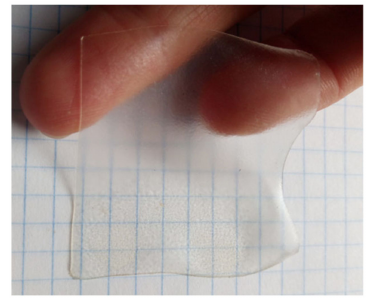
Figure 4. Picture of CMS / CMC 50 / 50